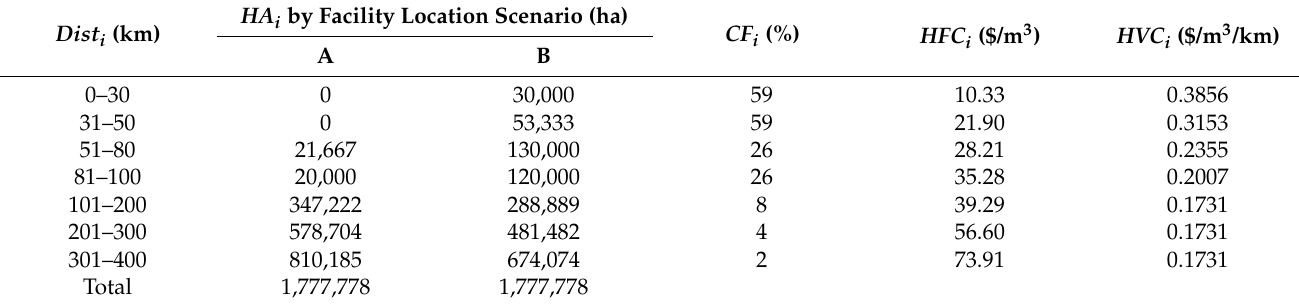
Table 4. Forest area, competition factor and haul costs by haul distance from the